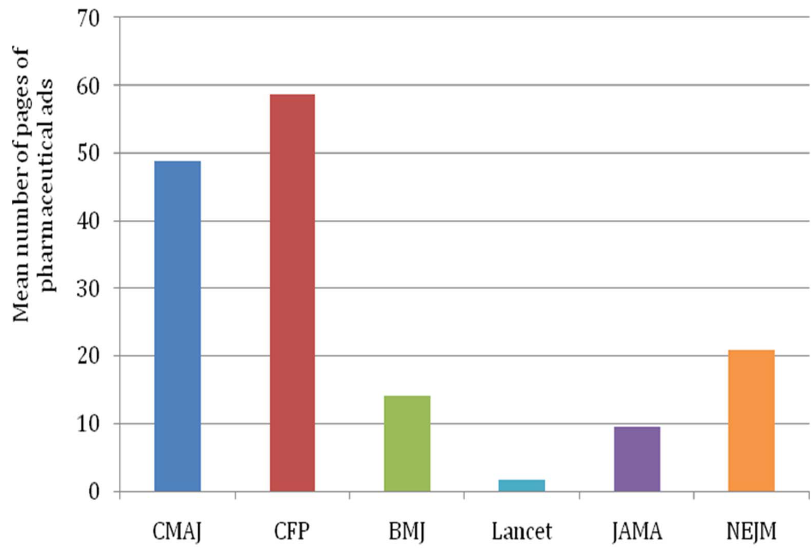
Figure 1. The mean number of pages of pharmaceutical ads, 2007 to 2012.